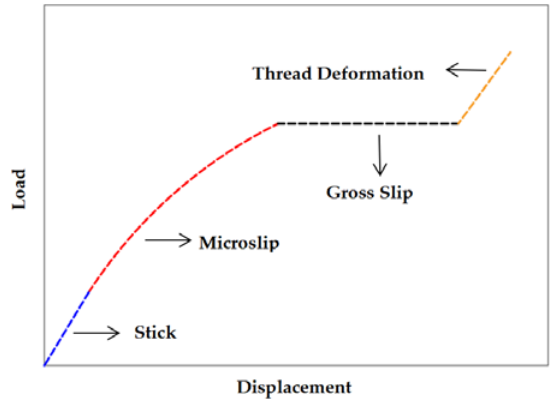
Figure 3. Force–displacement relation curve for the premium connection.